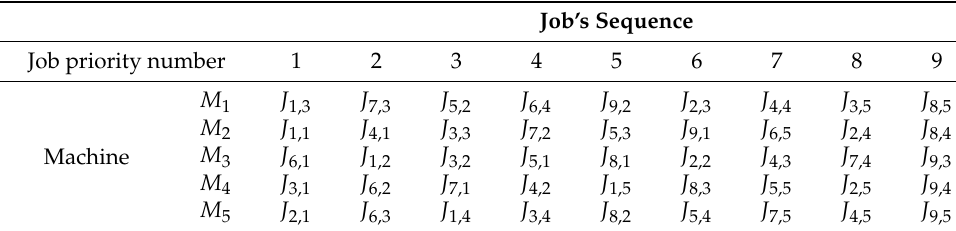
Table 7. The job’s operation sequence in relation to machine priority number.